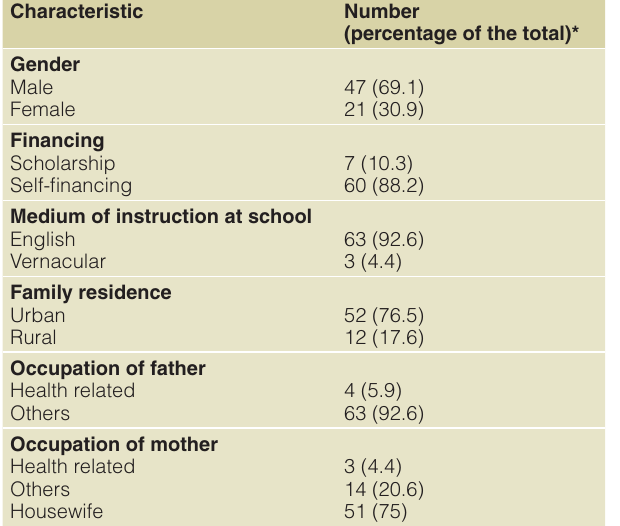
Table 1. Demographic characteristics of student respondents. * The numbers may not add up to 68 and the percentage to 100 in all cases as certain respondents did not complete all demographic details.